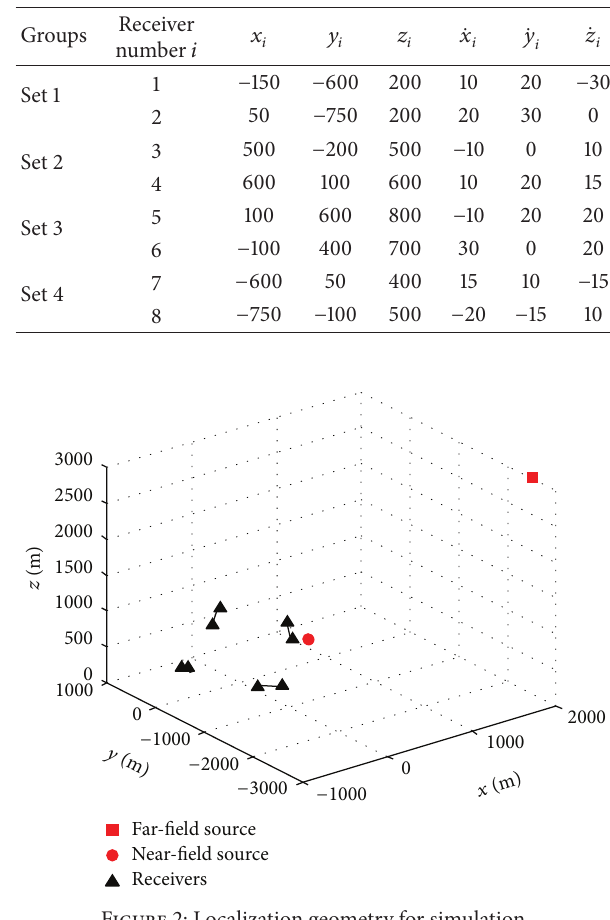
Table 1: Nominal position (in meters) and velocities (in meters/ second) of receivers.